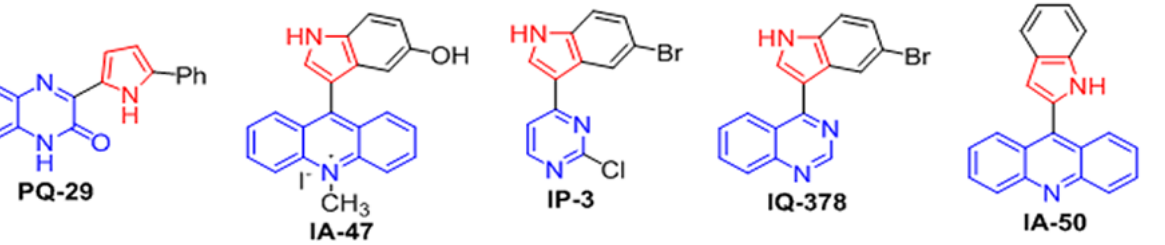
Figure 2. Examples of pyrrolyl ‐ and indolylazines demonstrating chaperone ‐ inducing activity. The fragments of pyrrole are marked in red. Table 1. Computationally predicted absorption, distribution, metabolism and excretion (ADME), and other drug ‐ likeness profiles of pyrrolyl ‐ and indolylazine.